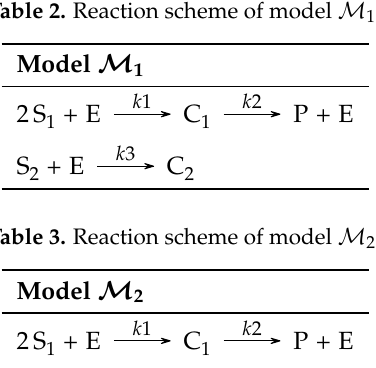
Table 2. Reaction scheme of model